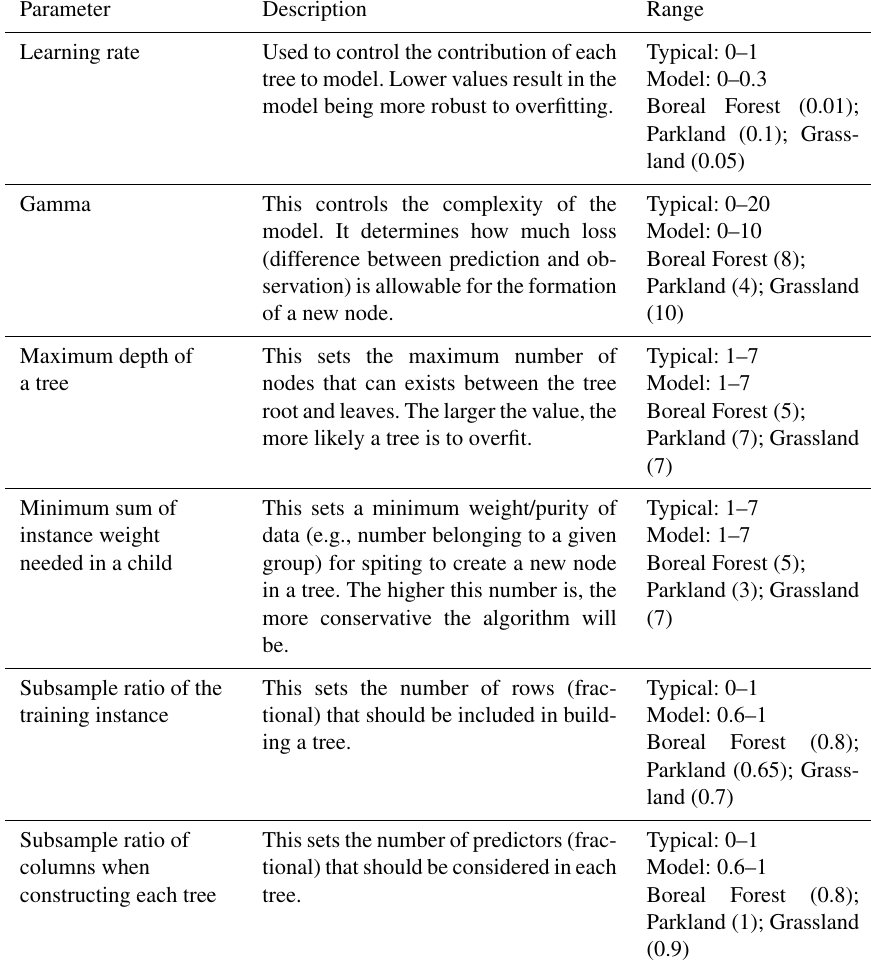
Table C1. List of parameters tuned for the extreme gradient boosting model, a description of these parameters, their ranges and the ranges evaluated in our cross